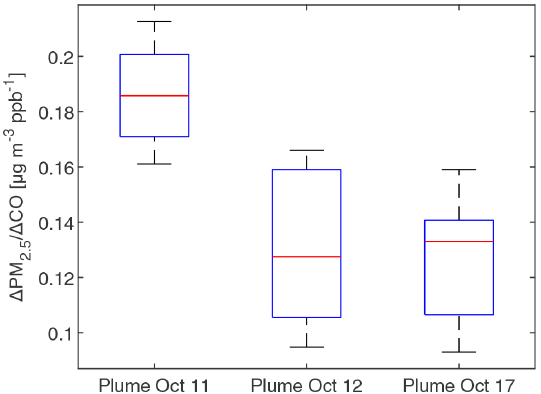
Figure 10. Boxplot of the (cid:49) PM 2 . 5 / (cid:49) CO ratios in µgm − 3 ppb − 1 at BAAQMD sites in the three plumes described in Fig. 2. (cid:49) PM 2 . 5 / (cid:49) CO ratios were obtained by linearly fit PM 2 . 5 versus CO during plumes (using R 2 = 0.9 as the threshold). The top and bottom edges of the box indicate the 75th and 25th percentiles, re- spectively. The central red mark is the median. Whiskers extend out of the boxes to 1.5 times the interquartile ranges. There was no out- lier in the data.